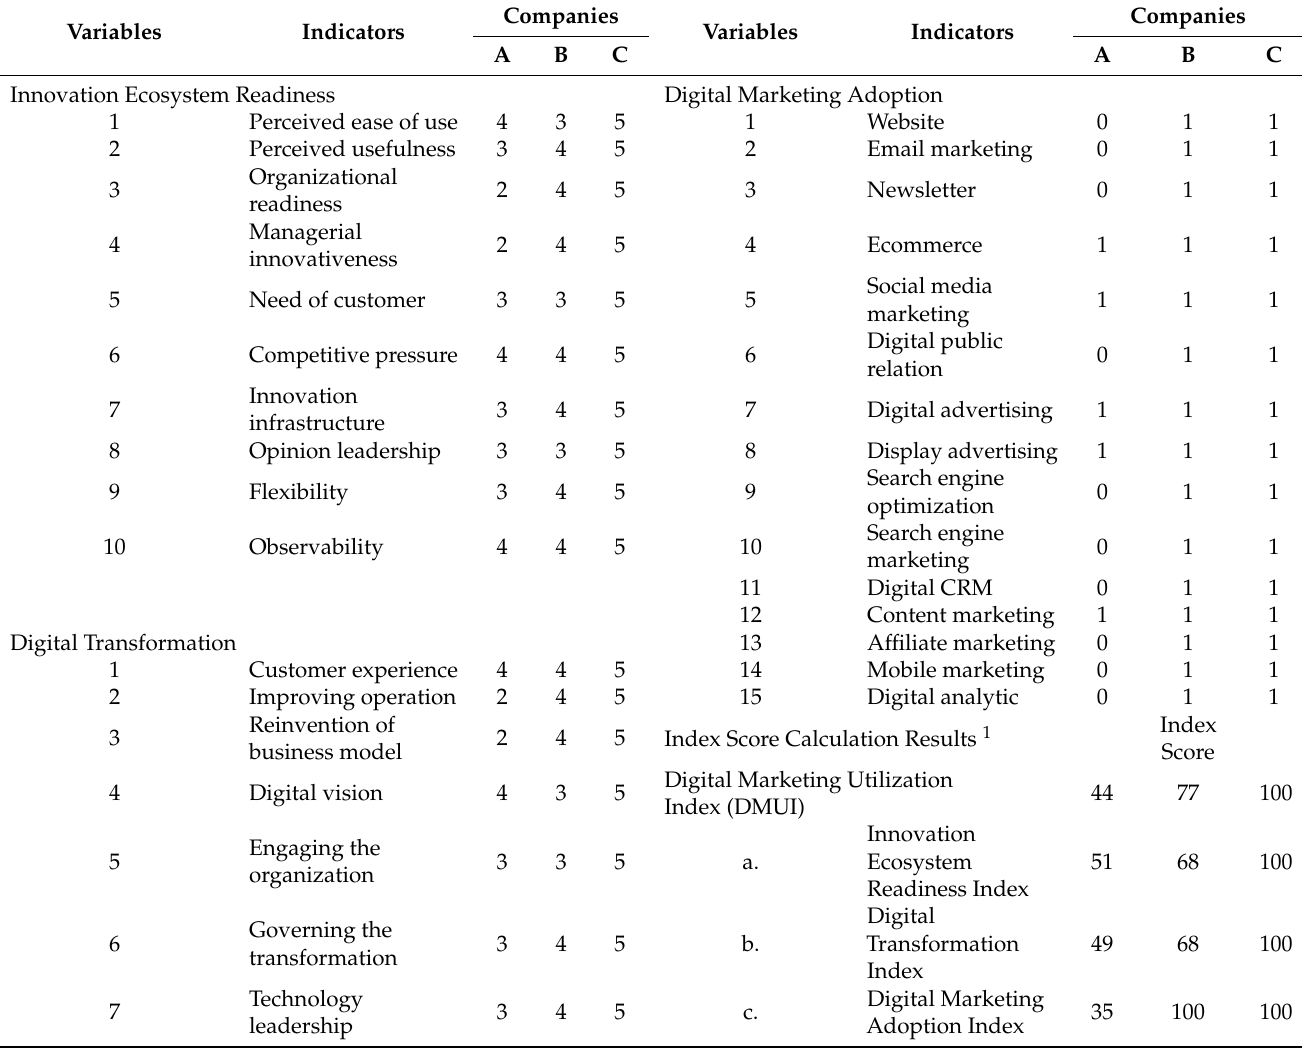
Table 7. Digital Marketing Utilization index score